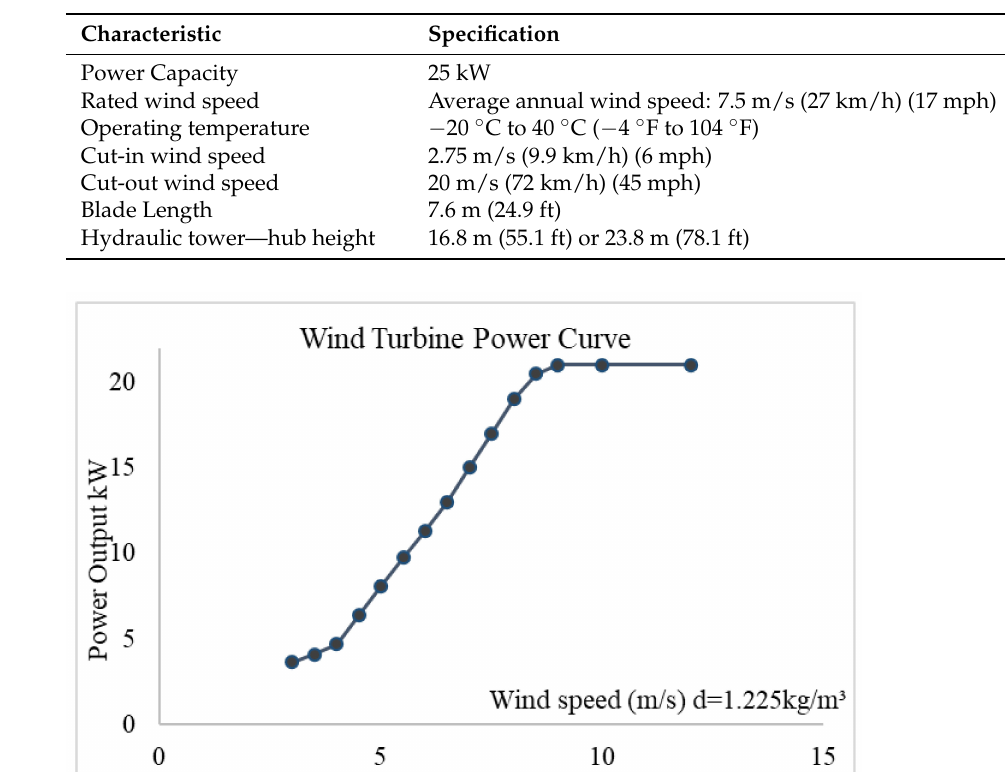
Figure 6. The power–speed curve of the wind